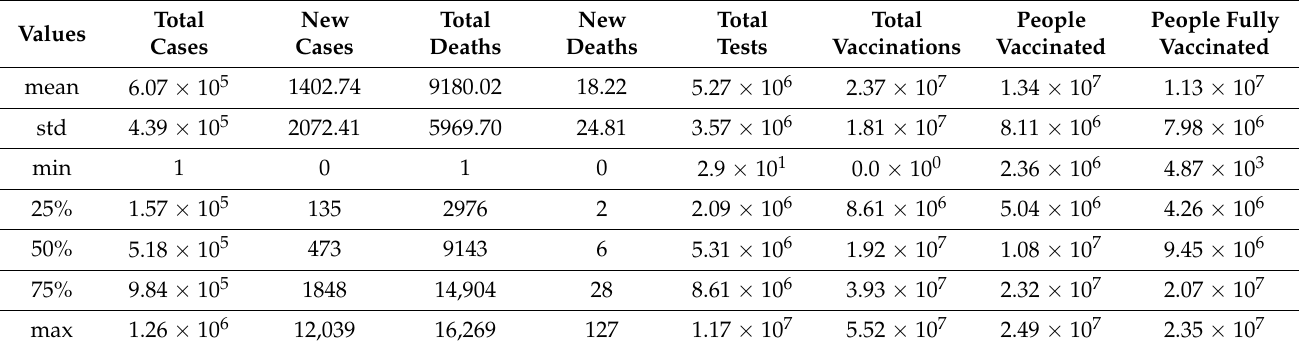
Table 6. Morocco summary statistics per